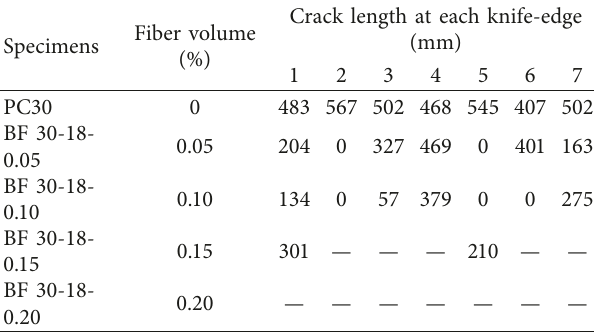
Table 9: Crack resistance indices of test specimens with different fiber volume